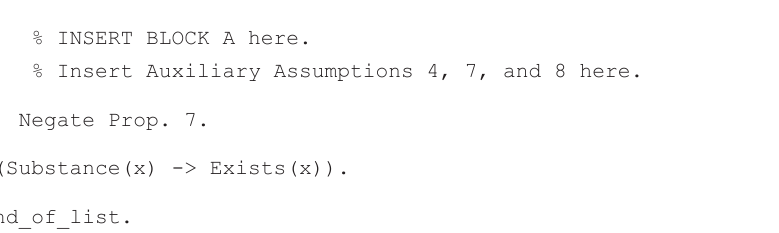
Figure 8: A mace4 script that shows (SE) is independent of the DAPI conjoined with Auxiliary Assumptions 4,7, and 8 (i.e., (SE) is independent of the assumptions used to derive (GE)).